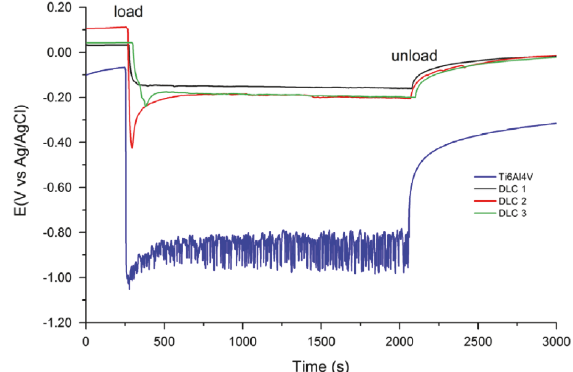
Figure 7: Evolution of the open circuit potential before, during, and after sliding wear test for a Ti6Al4V alloy with different DLC coatings in PBS solution. Sliding removes the passive layer on the surface, leading to a decrease in the potential value. At the end of sliding, the material is repassivated, and the potential increases to reach values close to those before sliding